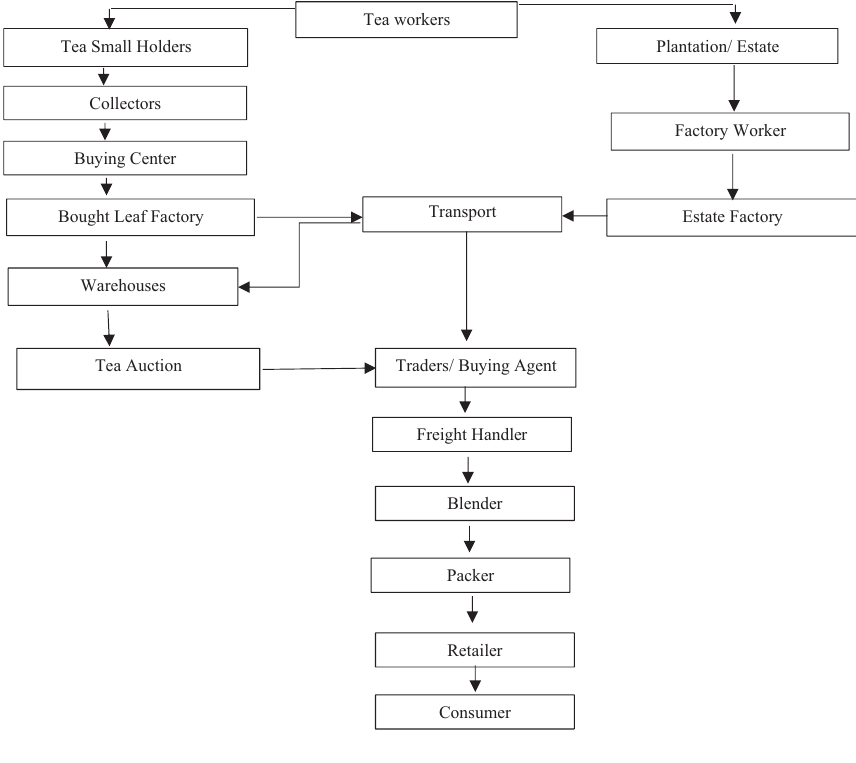
Figure 1. Tea supply chain